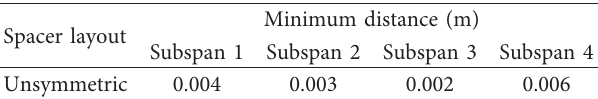
oscillation of the iced twin bundle conductor Table 9: The minimum distance at each subspan midpoint between